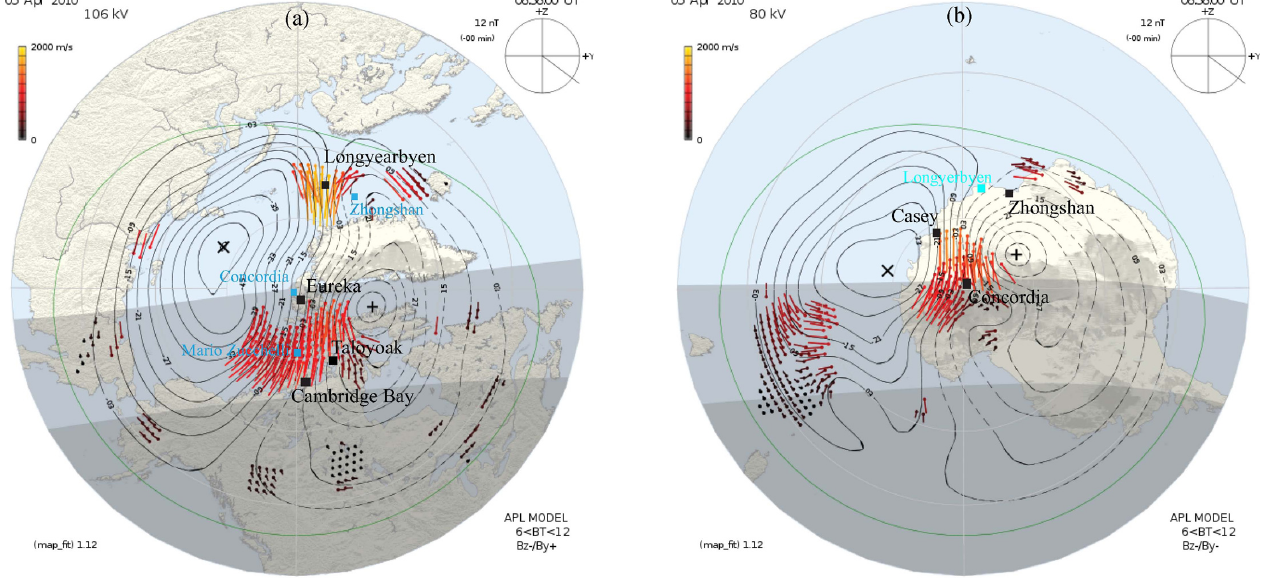
Fig. 4. (a) Northern and (b) Southern Hemisphere SuperDARN convection and potential maps after the upstream shock arrival. CGM coordinates are used and 12:00MLT is at the top. Solar terminator at sea level and F-region altitude is shown. F-region in darkness is shaded as darker grey.